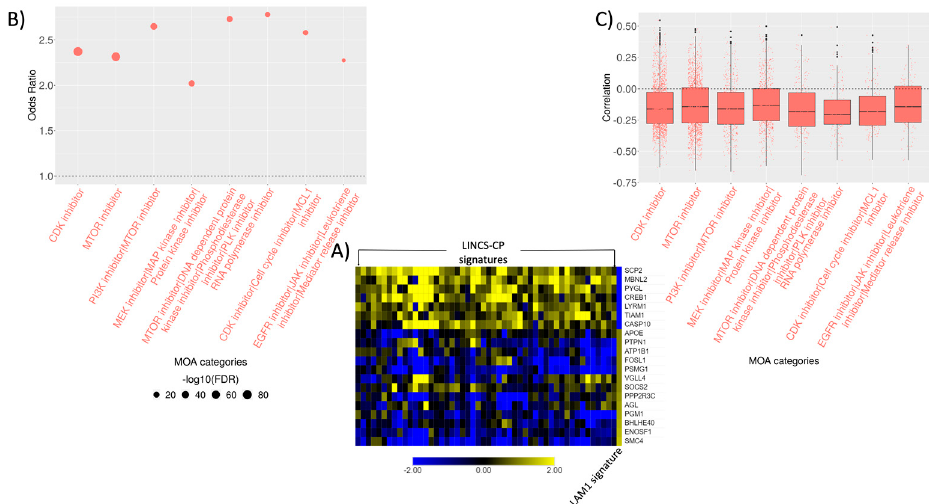
Figure 3. Connectivity analysis of naïve LAM signature. ( A ) Top 250 most up/down regulated genes from LAM characterizing signature were selected and matched with 978 LINCS-L1000 landmark genes. Pearson’s correlation were computed between each of the LINCS-CP and LAM signature. Top 50 LINCS-CP signatures most negatively correlated with the LAM signature (columns) with the corresponding matched genes (rows) are presented via heatmap. ( B ) Odds ratios of the top most enriched MOA categories are shown via dot plot where the size of the dots represents the significance of the MOA categories with a bigger dot indicating lower FDR adjusted p -value. MOA categories were selected based on odds ratio > 2, –log10(FDR) > 7, and at least 100 signatures in any MOA category. ( C ) Distribution of the overall signature correlations associated with each of the MOA categories is demonstrated via box-and-whisker plots. Each dot represents a LINCS-CP signature and negative correlations indicate the potential of the drug mechanisms to revert the LAM signature.